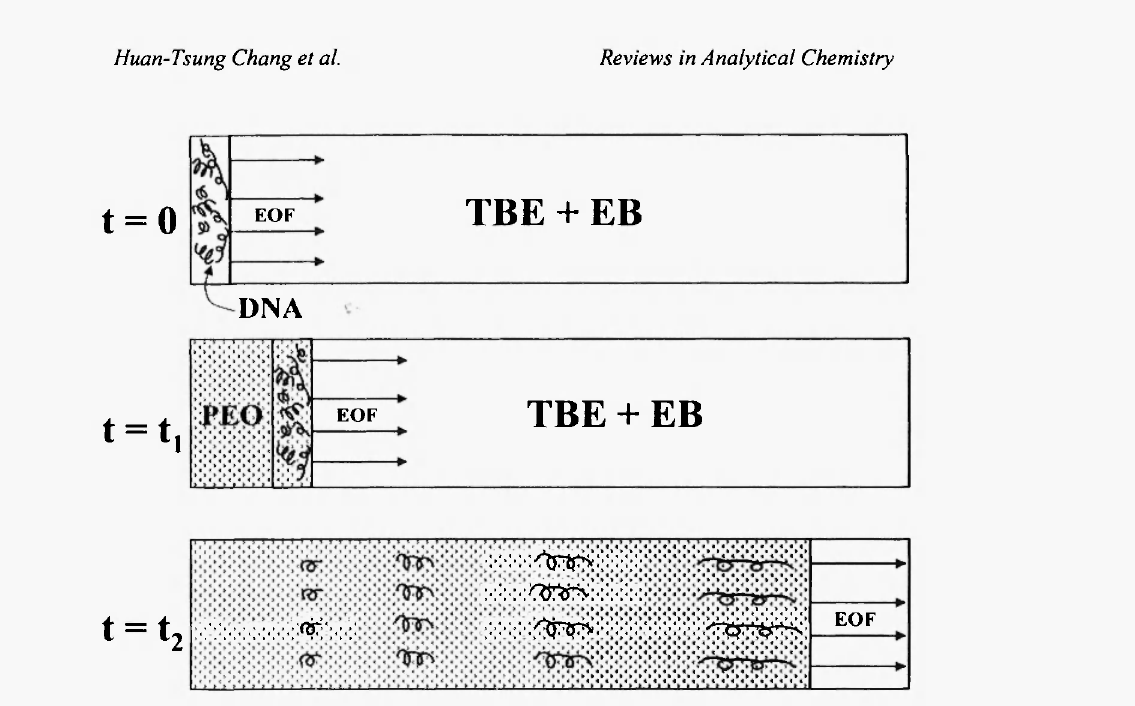
Fig. 5: Illustration of separation of DNA fragments using PEO solutions in the presence of EOF. Top: DNA sample is injected into a capillary filled with TBE buffer only; Middle: PEO solutions are moved into the capillary by EOF and serve as sieving matrices for DNA separation after a short period of time; Bottom: some DNA fragments migrate through different zones of PEO solutions after another PEO solutions are migrated into the